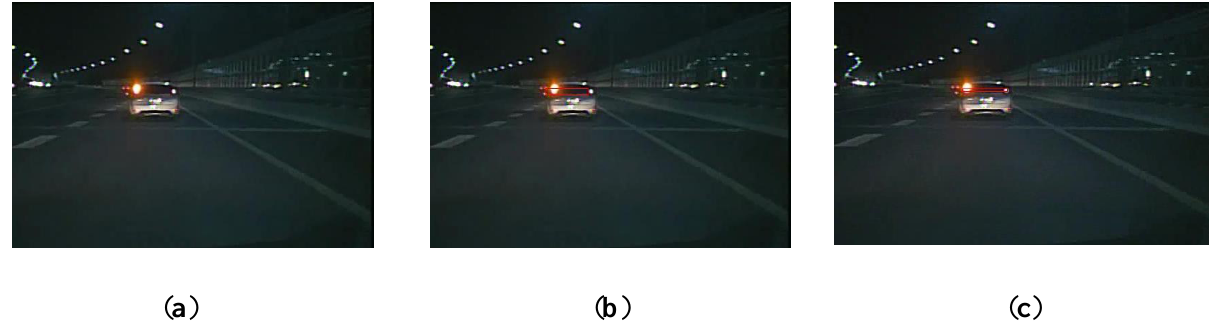
Figure 12. Comparison of vehicle detection results (case 3): ( a ) Result using the global rule-based algorithm; ( b ) Result using Kalman tracking-based global algorithm; ( c ) Result using the proposed algorithm.